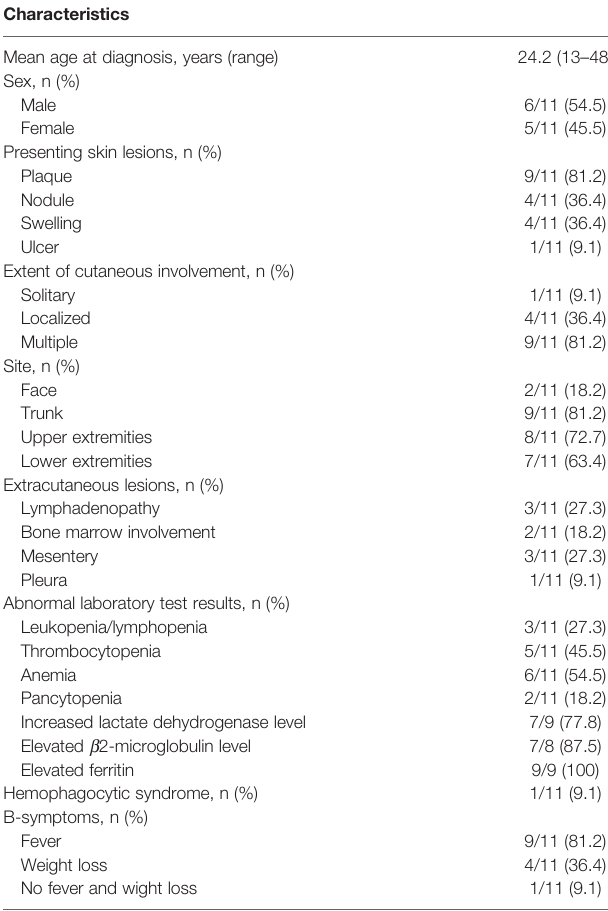
TABLE 1 | Clinical features and laboratory results of the 11 patients with subcutaneous panniculitis-like T-cell lymphoma.